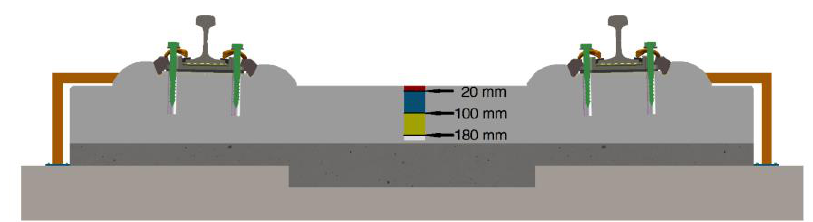
Figure 11. Diagram of the installation positions of the temperature sensors.